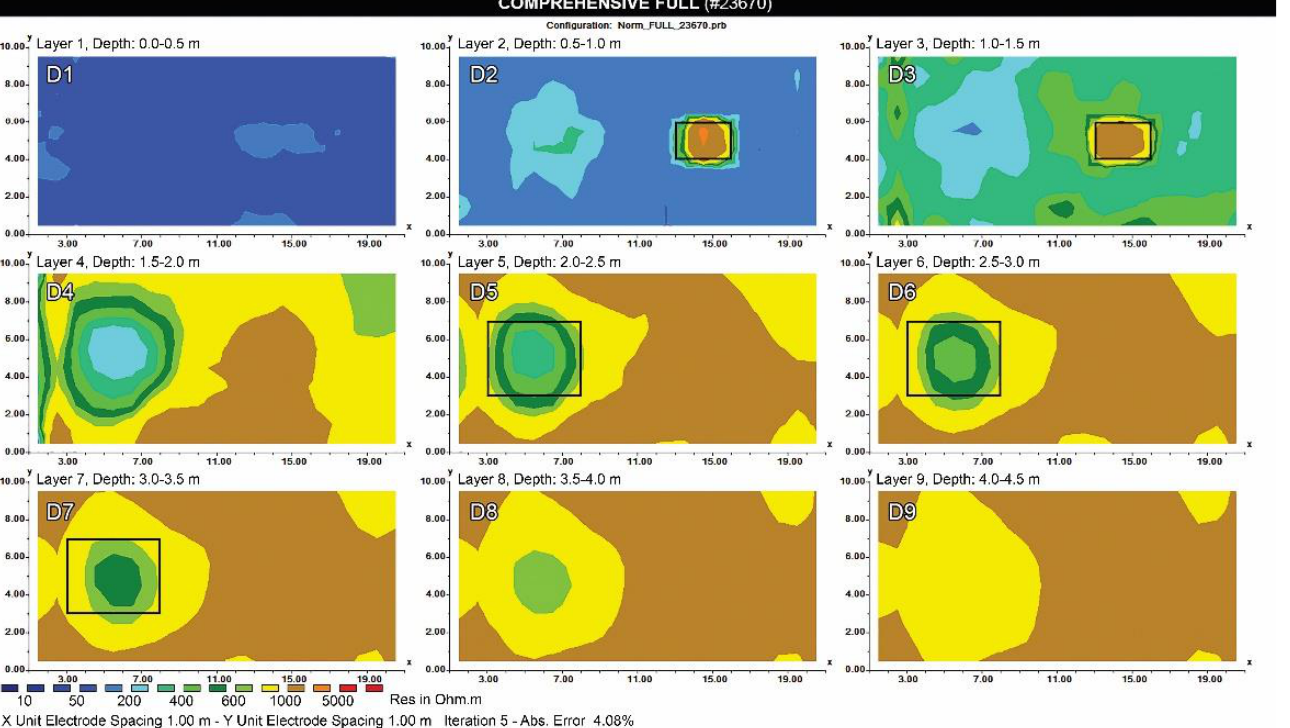
Figure 6. Inversion results from FULL comprehensive array.